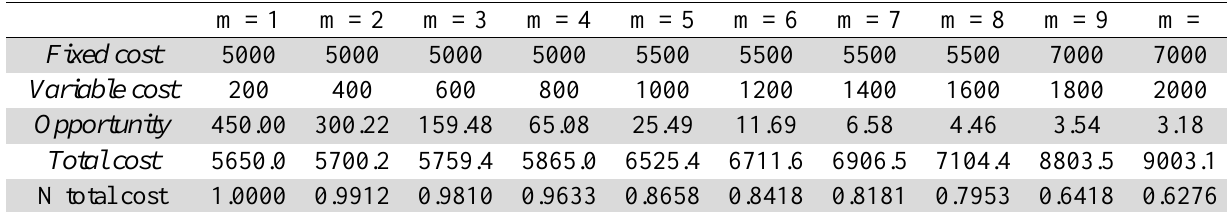
Normalized Values of System